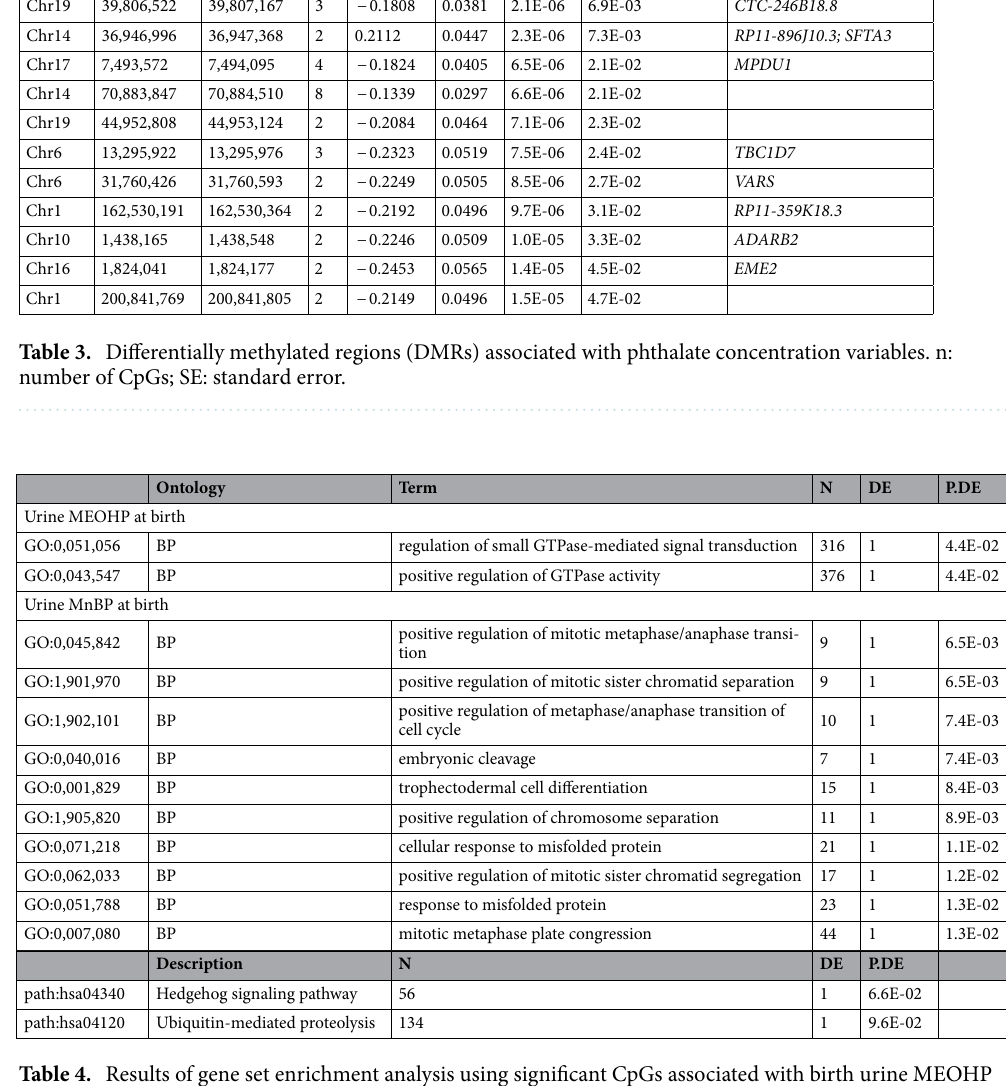
Table 4. Results of gene set enrichment analysis using significant CpGs associated with birth urine MEOHP and MnBP concentrations. The top ten gene ontology (GO) and Kyoto Encyclopedia of Genes and Genomes (KEGG) terms under α = 0.05 are shown. BP: Biological Pathway; N: number of CpGs; DE: differentially methylated CpGs; P.DE: p